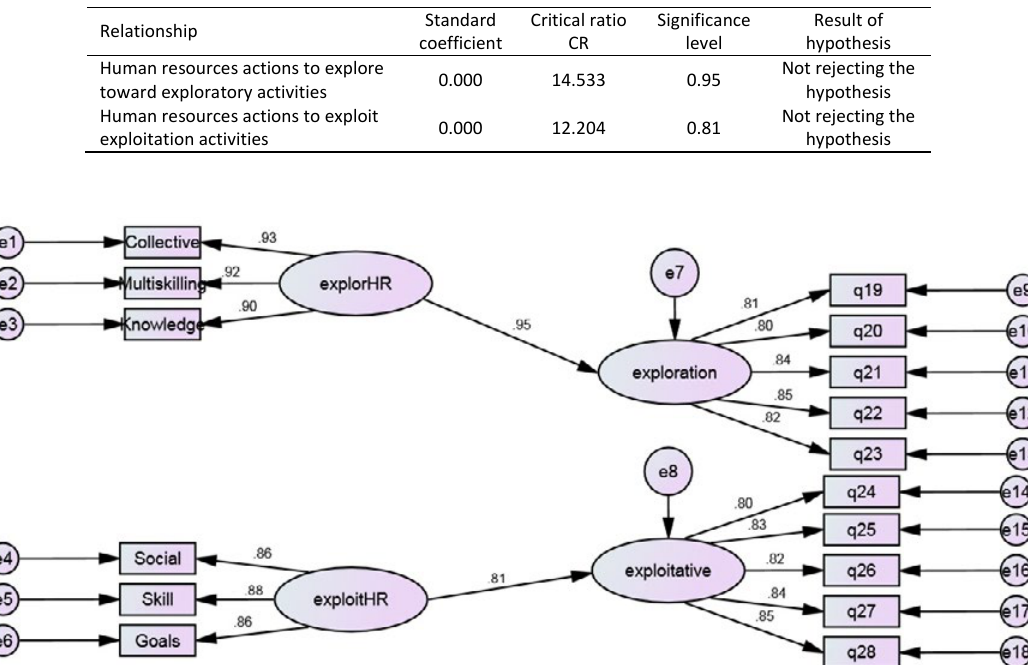
Fig. 2. Conceptual model of research along with factor Fig. 2: conceptual model of research along with factor load